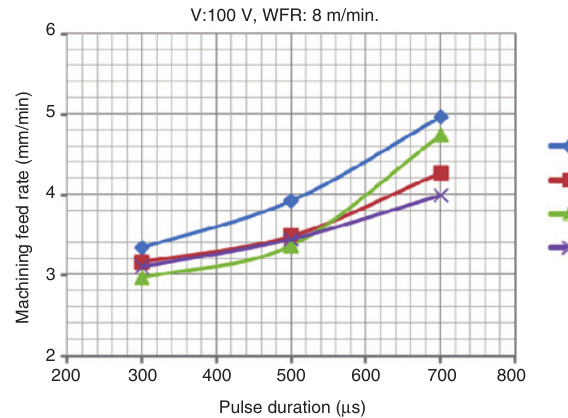
Figure 9 Machine feed rate: pulse duration.